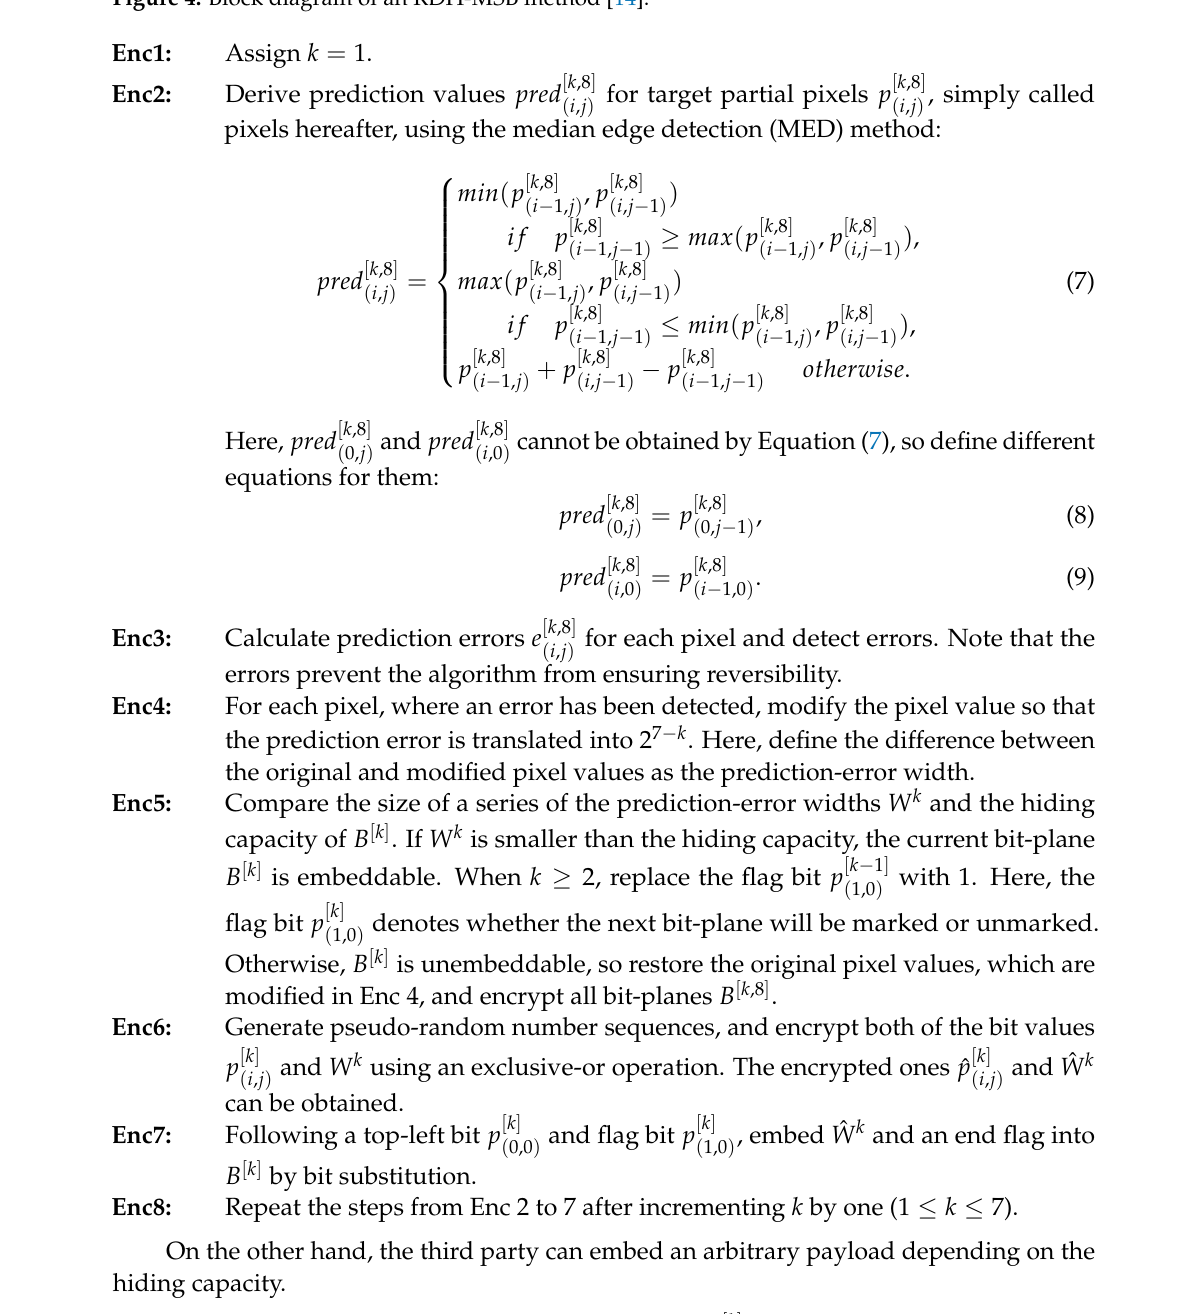
Figure 4. Block diagram of an RDH-MSB method